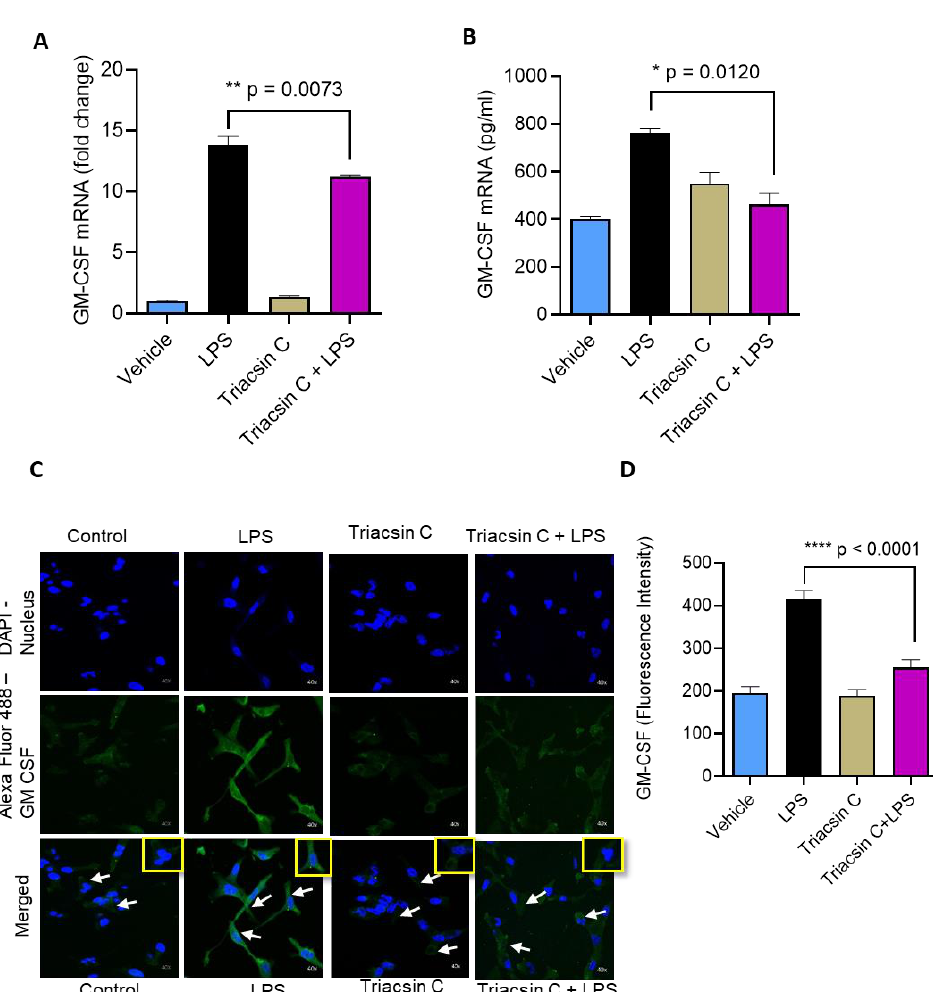
Figure 2. Effect of acyl-CoA synthetase 1 (ACSL1) inhibition on LPS mediated GM-CSF production in MDA-MB-231 cells. MDA-MB-231 cells were pretreated with a long chain acyl-CoA synthetase (ACSL1) inhibitor (triacsin C: (1 μM) or vehicle for 1 h and then incubated with LPS for 24 h. ( A ) Total cellular RNA was isolated, and GM-CSF mRNA expression was determined by real-time RT-PCR. ( B ) Secreted GM-CSF protein in culture media was determined by ELISA. ( C ) Representative figures for confocal microscopy. MDA-MB-231 cells were stained with GM-CSF (green) and DAPI (blue). White arrows indicate typical stained cells. White arrows indicate typical stained cells. ( D ) GM-CSF fluorescence intensity was determined for 10 random images. All data are expressed as mean ± SEM (n ≥ 3). * p < 0.05, ** p < 0.02, **** p < 0.001 versus vehicle.